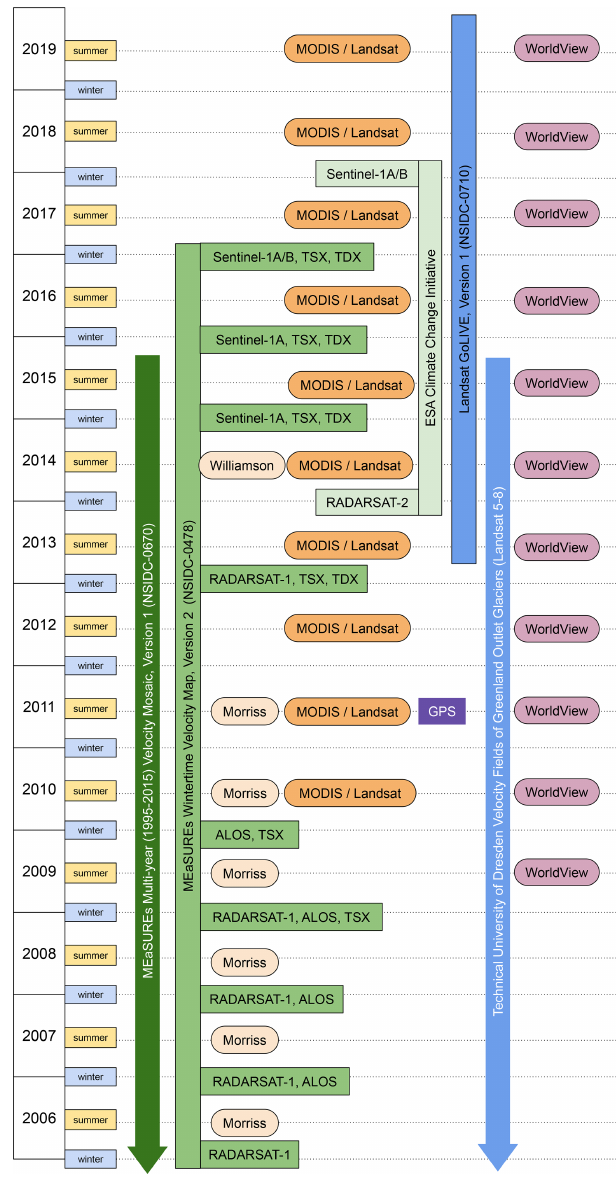
Figure 1. Datasets used in this analysis, organized by year and sea- son. We calculate strain rates from SAR-based velocity mosaics (green; data provider and satellite sources noted), which are based on wintertime data, as well as from optically based velocity mo- saics (blue), which are available during seasons with solar illumi- nation. Lake drainage data sources are shown in orange; Morriss refers to Morriss et al. (2013), and Williamson refers to Williamson et al. (2018b). The Morriss et al. (2013) record begins in 2002 (not shown). We overlap with one complete field season (2011) of GPS- derived strain rates (purple), from Andrews et al. (2014, 2018). We use high-resolution, July–October WorldView images (light pur- ple), when available, to locate the moulins that drain the lakes in our study area each